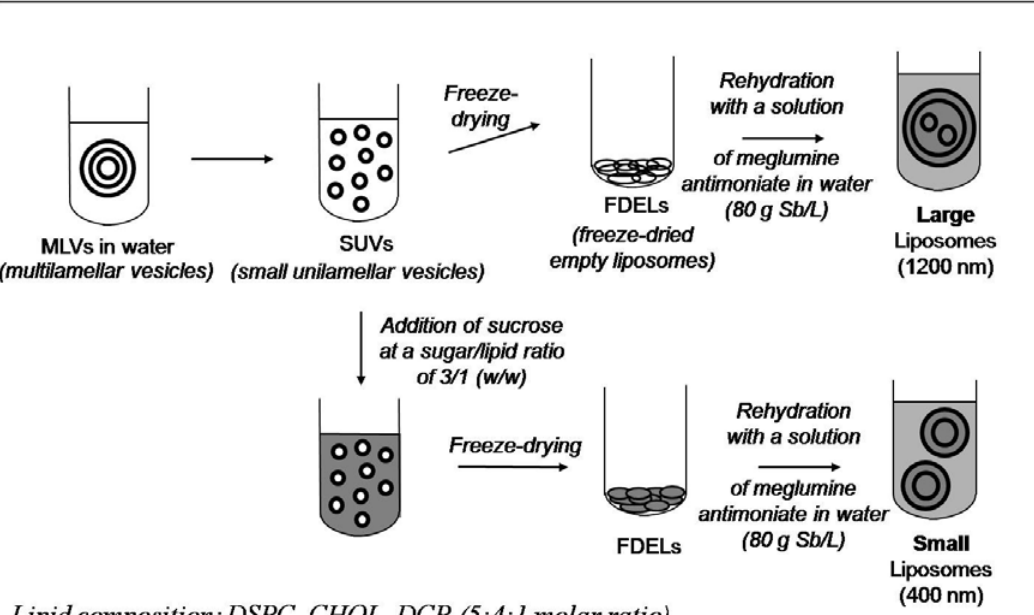
Figure 3. Processes used for the preparation of meglumine antimoniate-containing liposomes of different size. Adapted from Ref.